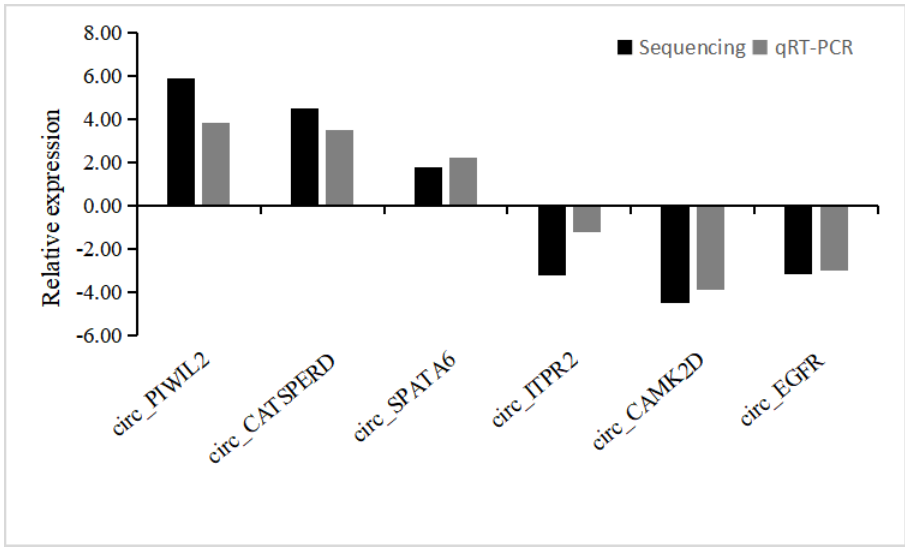
Figure 3. Validation of DE-circRNAs by qRT-PCR. Histograms of the relative expression levels. The y-axis shows the fold change between two groups (log( − ΔΔCt,2) for qRT -PCR, log 2 (fold change) for sequencing). In total, the qRT-PCR results were consistent with the RNA-seq results.